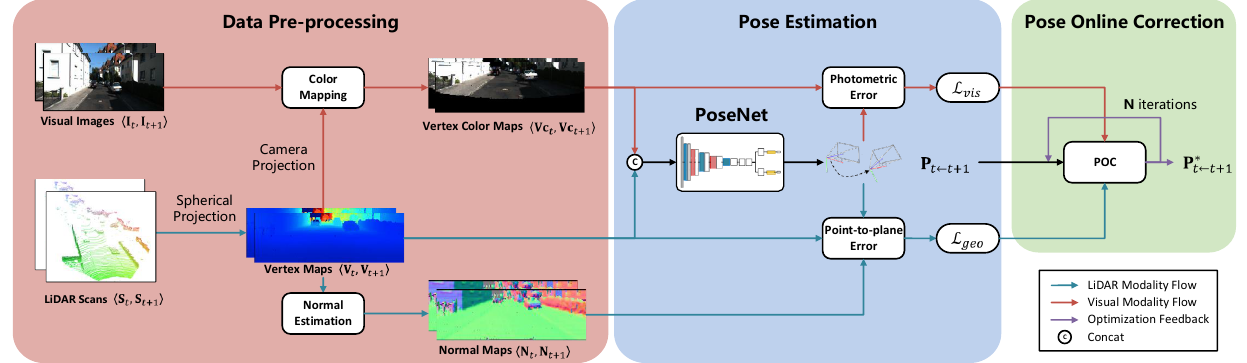
(cid:105) , normal maps (cid:104) N t , N (cid:105) , as t + 1 t + 1